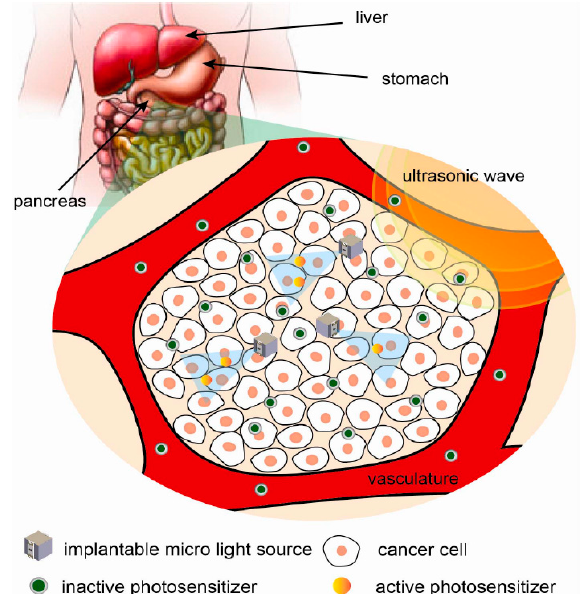
Figure 49. Proposed system showing several implantable micro-light sources to activate the Figure photosensitizer deep inside a tumor powered by ultrasonic wave [207]. Copyright © 2015, IEEE.